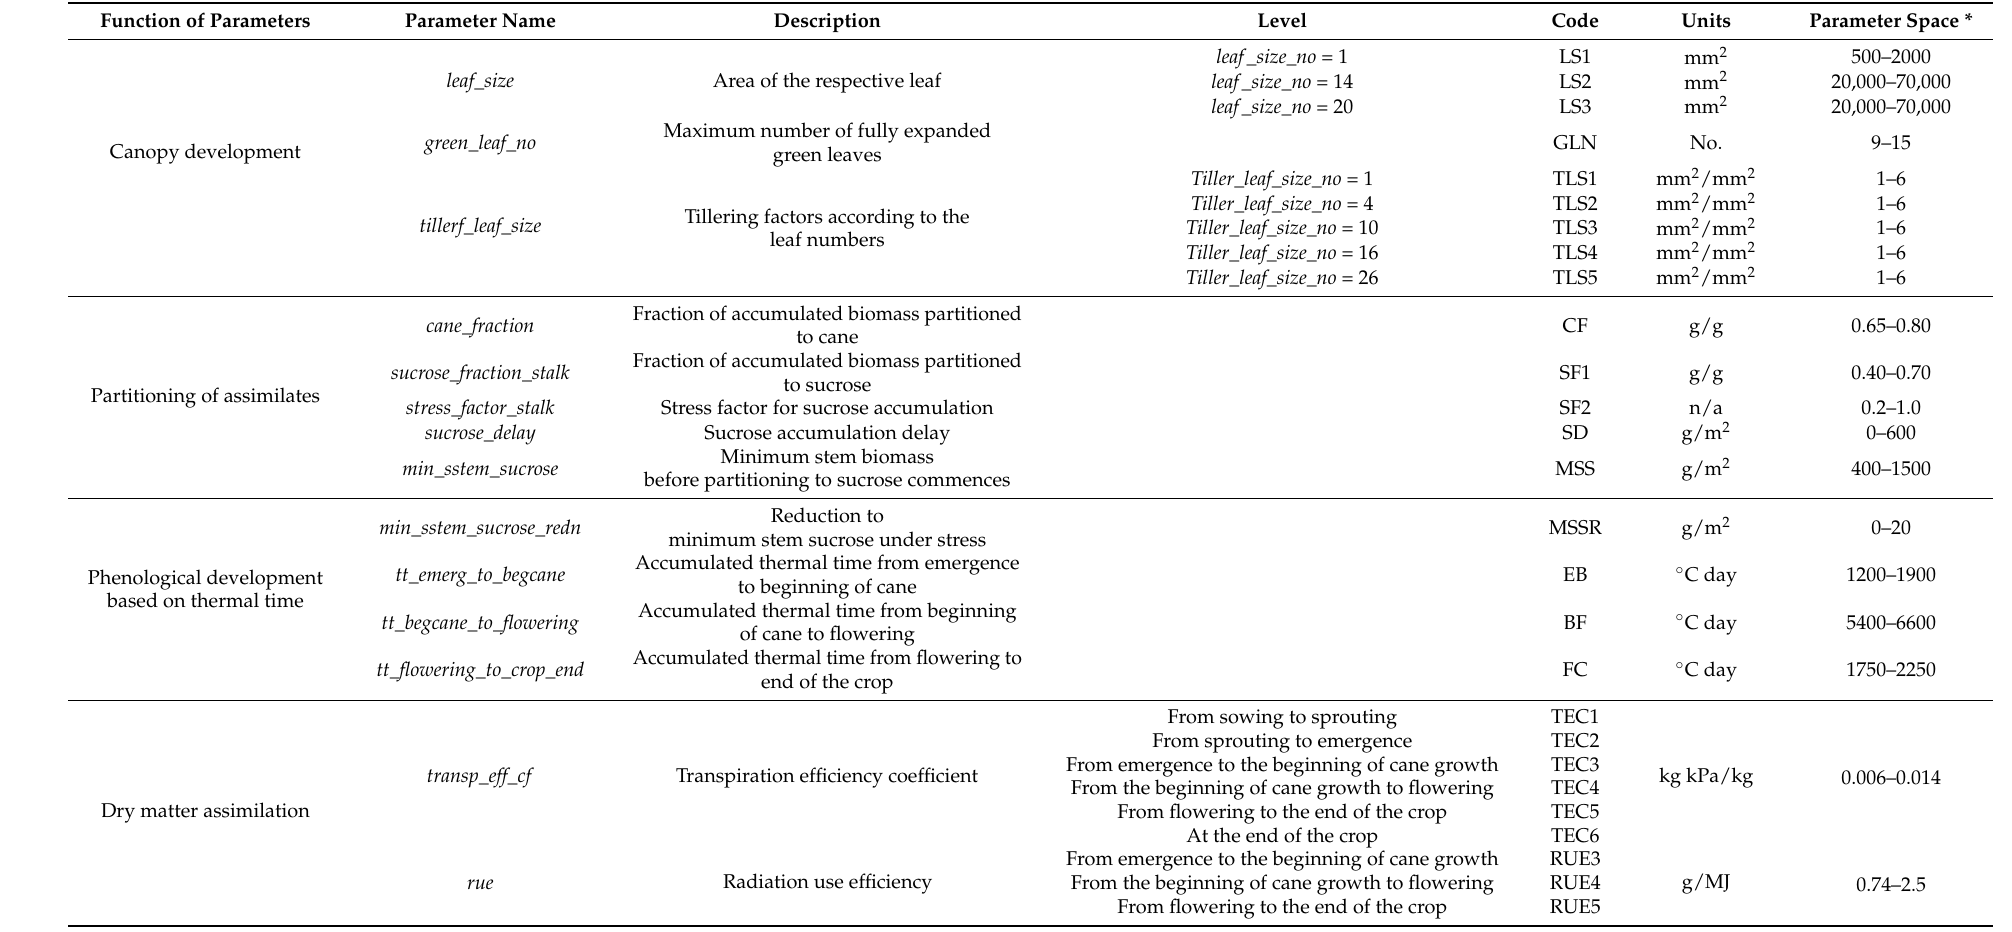
Table 3. Description of trait parameters used in the APSIM-Sugarcane model and parameter